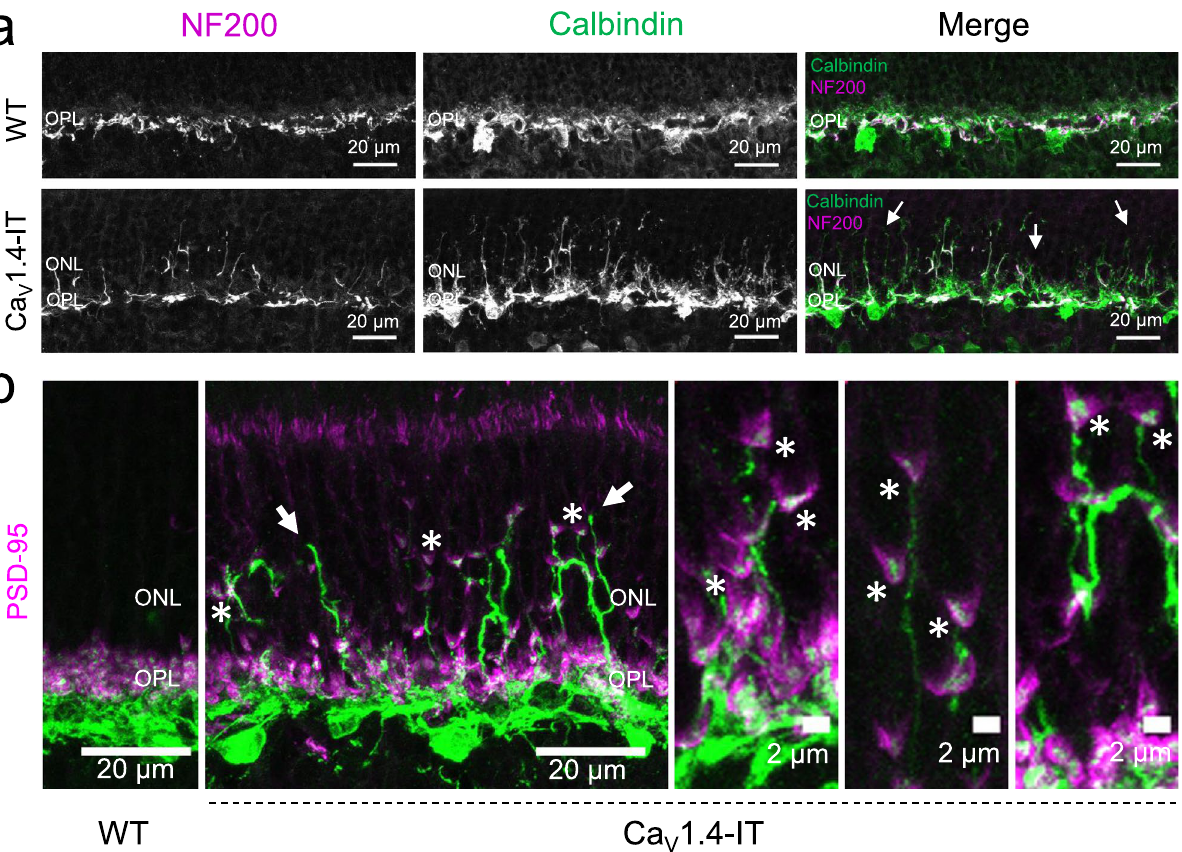
Figure 6. Axonal sprouting of horizontal cells in Ca V 1.4-IT retinas. ( a ) Double-labelling of horizontal cell processes with neurofilament 200 (NF200) and calbindin in wild type and Ca V 1.4-IT retinas. The white labelling in the merge shows that in Ca V 1.4-IT retinas Calbindin-labelled processes (green) were mostly overlapped with the NF200 (magenta) labelling indicating an axonal origin of the majority of sprouting horizontal cell processes. Arrows indicate dendritic sprouts of horizontal cells. WT: N = 4, Ca V 1.4-IT: N = 4. ( b ) The sprouting processes approached displaced rod spherules labelled with PSD-95 in the ONL (marked by *) with few exceptions (marked by arrows). WT: N = 4, Ca V 1.4-IT: N =